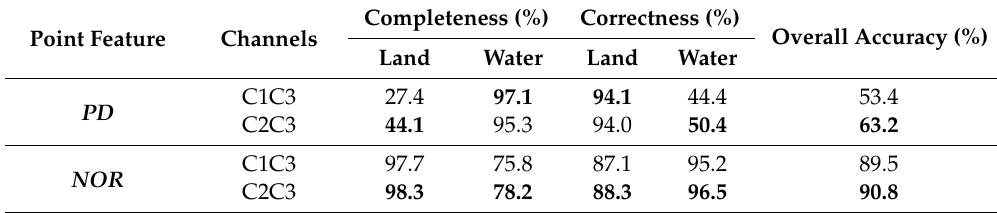
Figure 7. Labeled LiDAR points based on PD and NOR . Table 7. Accuracy measures of labeled points based on PD and NOR . The best results are highlighted in bold.